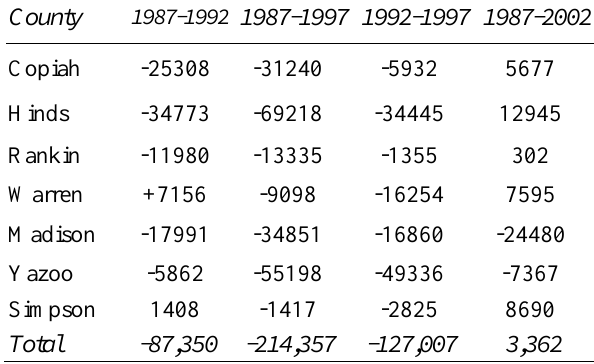
Table 1b: Change in Farm Acreage 1987-2000